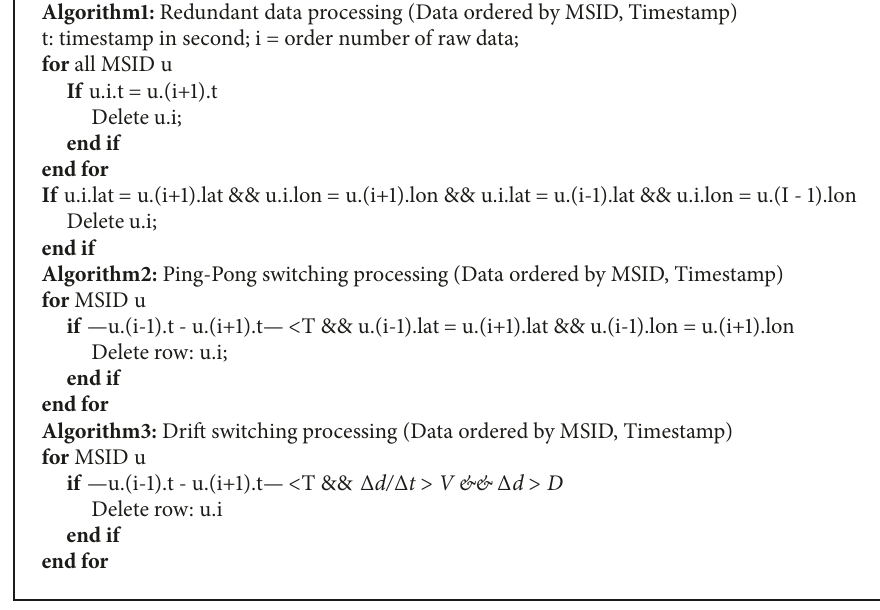
Algorithm1: Redundant data processing (Data ordered by MSID, Timestamp)